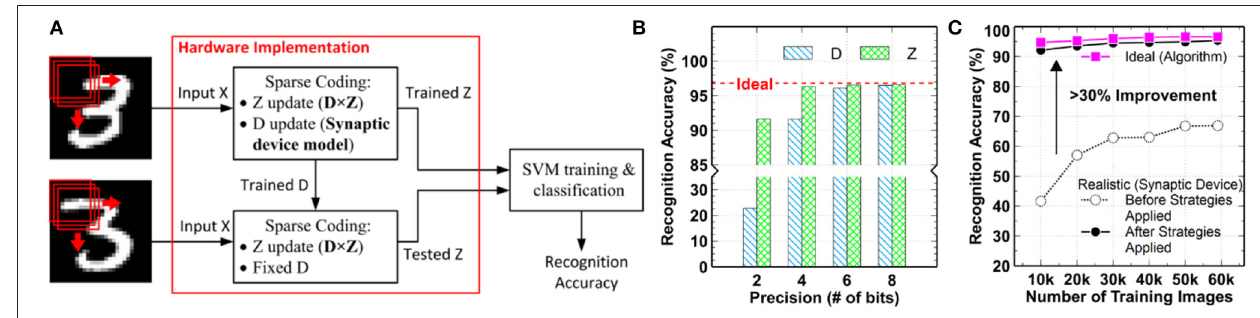
FIGURE 23 | Device-algorithm co-simulation flow. (A) Flow of sparse coding with non-ideal effects modeled in the algorithm. (B) Recognition accuracy as a function of precision of bits of the neuron vector (Z) and weight matrix (D). (C) Recognition accuracy with realistic device behaviors and the improvement by the proposed mitigation strategies. Adapted from (Chen et al.,